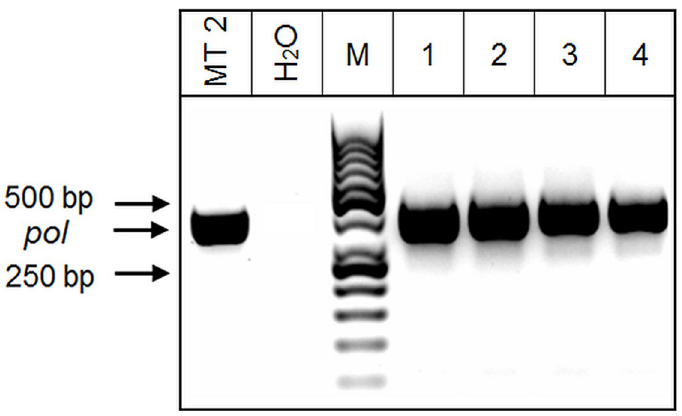
Fig 3. n-PCR for a pool of 10 samples in one PCR. MT2 (positive control), H 2 O (negative control), line 1: HAM/TSP sample, 2: ATLL sample, 3: HAM/TSP sample, 4: HTLV-1 asymptomatic sample. In each case, the amplification was made with 5ul (from 9 non HTLV-1 positive DNA and one HTLV-1 positive). The arrows point to the band of pol amplification and the 50 bp DNA Ladder (M).